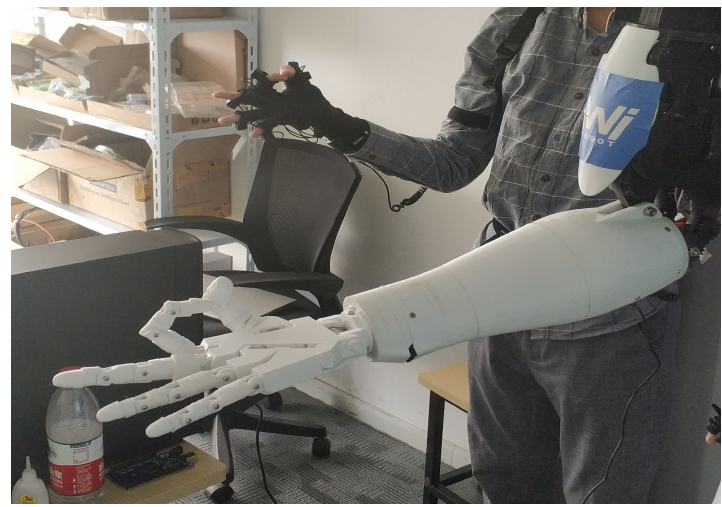
Figure 13. Comparison between fingers.